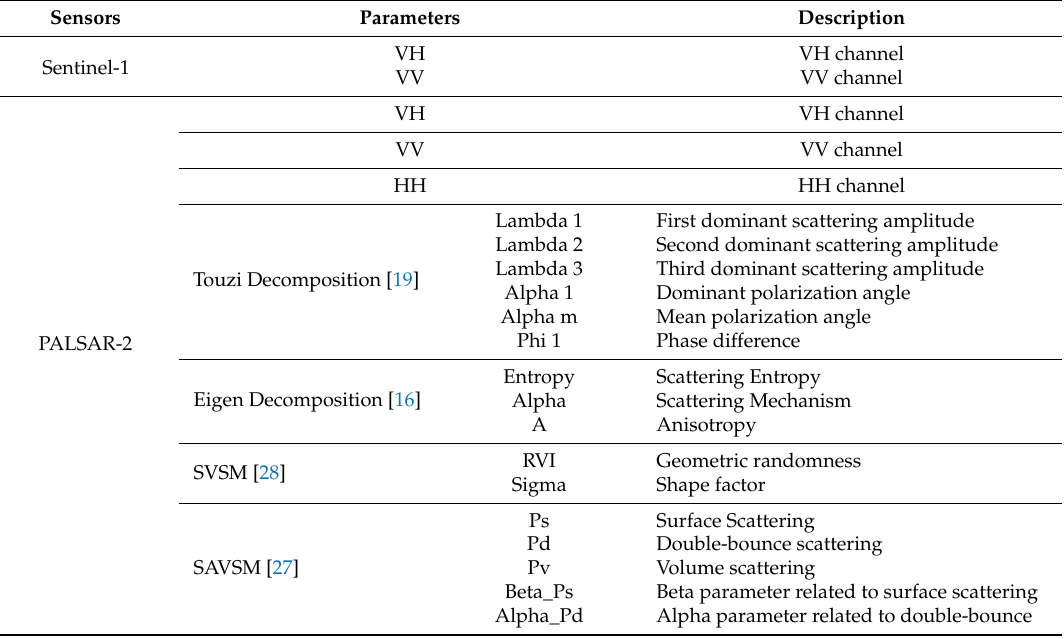
Table 2. SAR parameters from Sentinel-1 and PALSAR-2, in which the yellow highlighted parameters are the backscatter amplitudes that have been extensively investigated